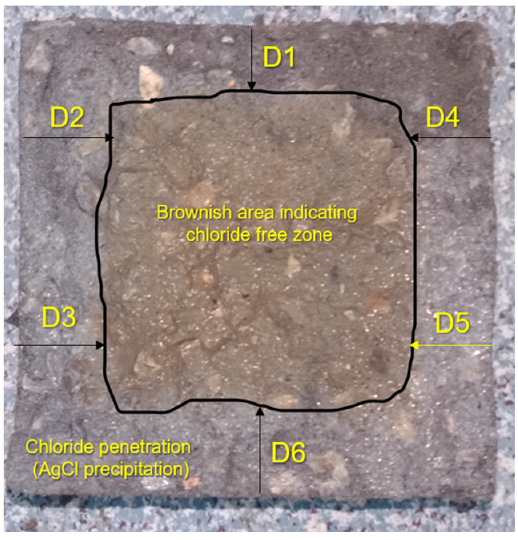
Figure 6. Chloride ion penetration in the concrete sample.